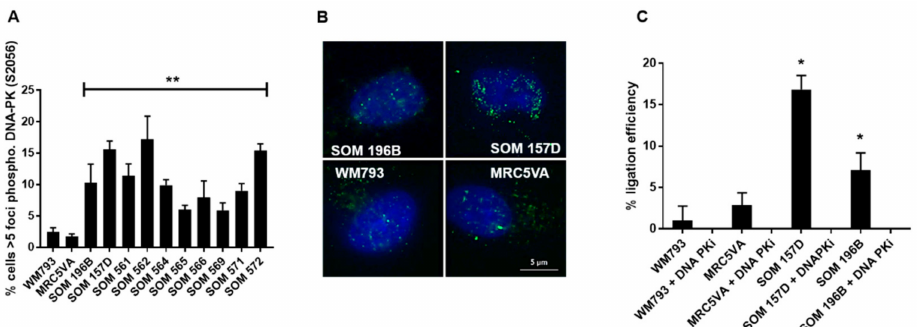
Figure 1. Non-homologous end joining (NHEJ) is elevated in uveal melanoma (UM) cell lines and short-term cultures (STCs). ( A ) UM cell lines and STCs showed greater formation of spontaneously activated serine 2056 DNA-PK foci compared to the control cells (** P < 0.01). The error bars represent the standard error from three independent trials. ( B ) Representative microscope images of cell lines stained for phosphorylated DNA-PKcs foci and counterstained with DAPI. The scale bar represents 5 microns. ( C ) NHEJ capacity assessed by the end-joining e ffi ciency assay. If the plasmid had been re-ligated then colonies successfully formed. The end-joining e ffi ciency (% ligation e ffi ciency) was significantly elevated in UM cell lines compared with the control cell lines WM793 and MRC5VA (* P = < 0.05). The end-joining capacity was eliminated in all cells treated with 10 µ M NU7026 DNA-PK inhibitor, confirming the validity of the assay for measuring NHEJ-mediated ligation.